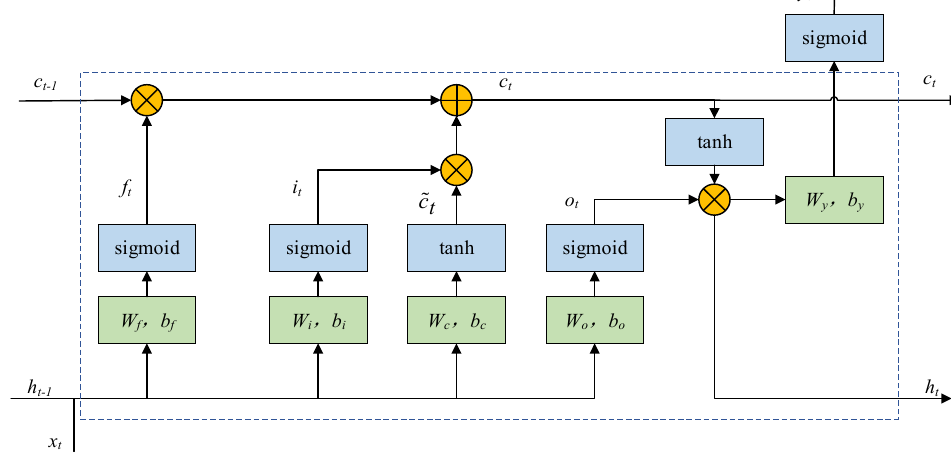
Figure 1. The structure of LSTM.